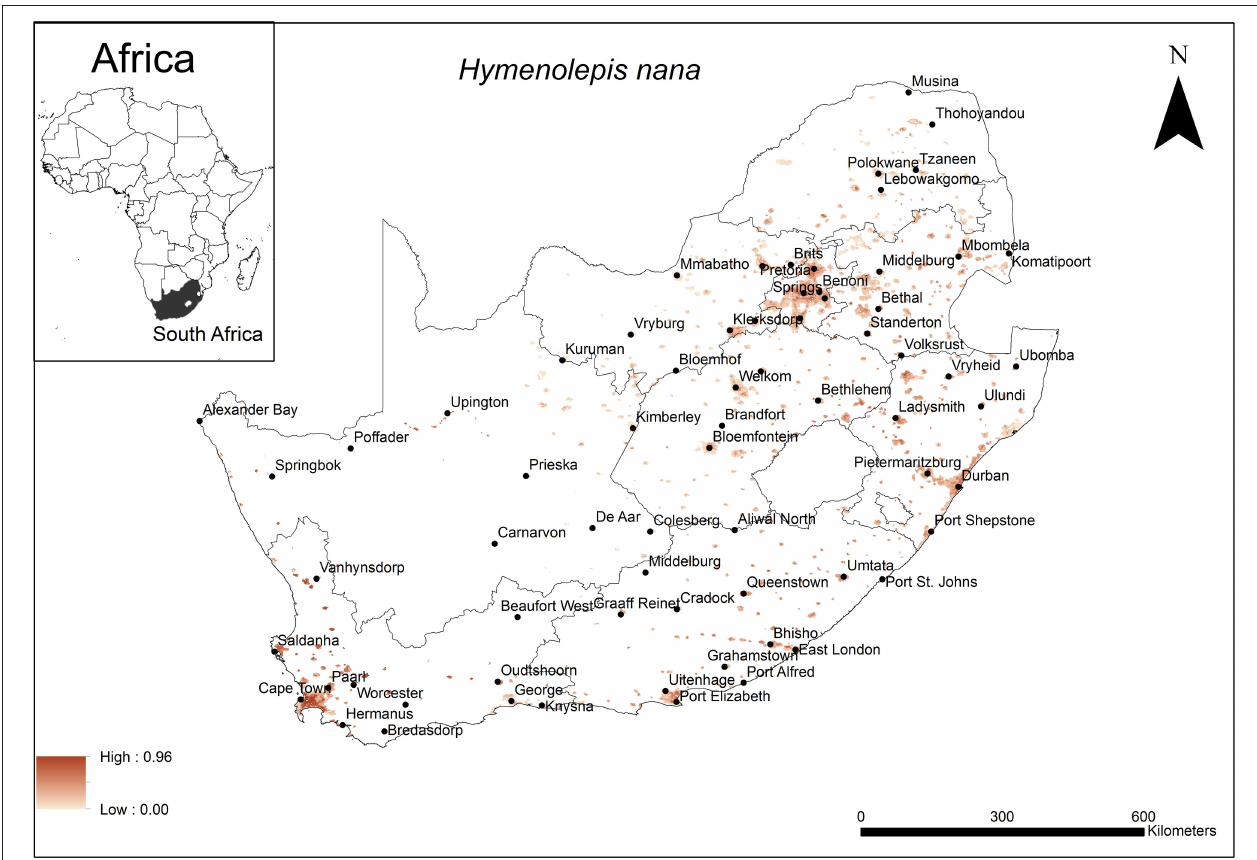
FIGURE 5 | A map showing predicted occurrence of H. nana in South Africa based on environmental suitability (shaded areas). White (non-shaded) areas represent areas where data were